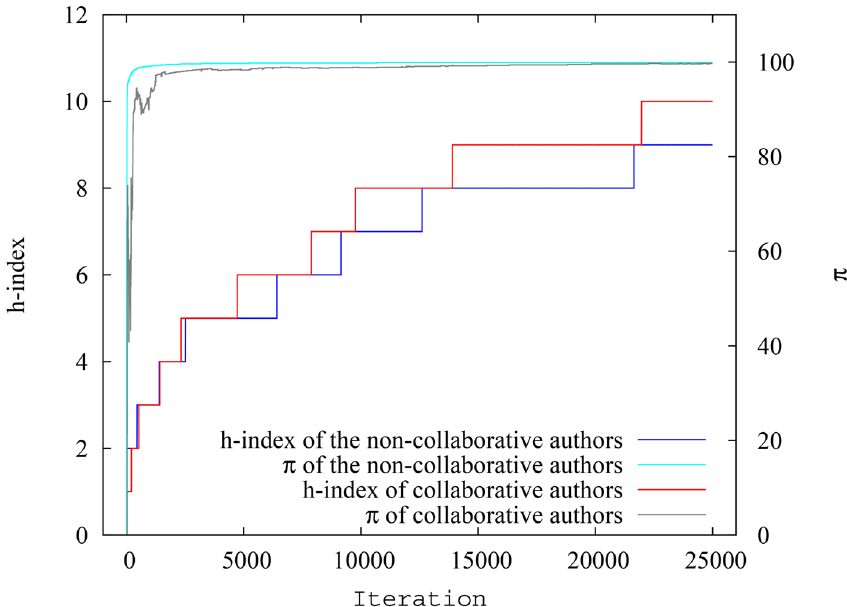
Fig 10. Variation of h-index and pagerank-index for highest ranking collaborative and non- collaborative authors at each timestep in simulation scenario 2. The difference between groups is much smaller when pagerank-index is